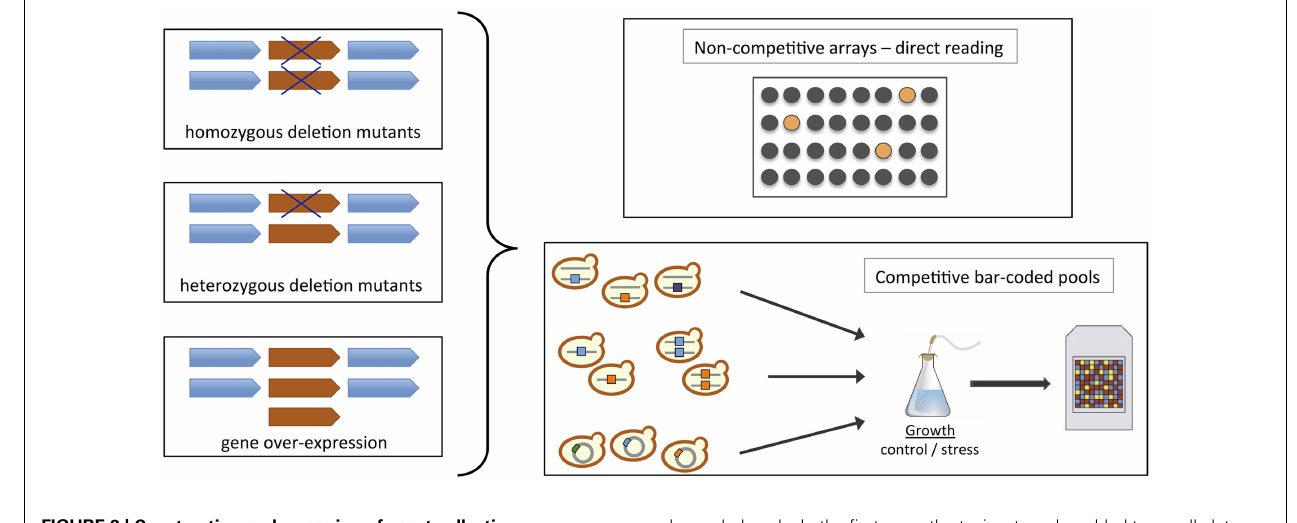
FIGURE 2 | Construction and screening of yeast collections. Schematic representation of methodologies and cell libraries available for chemogenomics testing in S. cerevisiae (homozygous or haploid deletion – gene dosage 0%, heterozygous deletion – gene dosage 50%, and overexpression – gene dosage > 100%; see Section “Functional Toxicogenomics usingYeast Gene Deletion Collections”; Auerbach et al., 2005; Hoon et al., 2008b;Wuster and Madan Babu, 2008; North and Vulpe, 2010; Smith et al., 2010).The fitness of strains upon chemical treatment is usually assessed in non-competitive arrays or in competitive